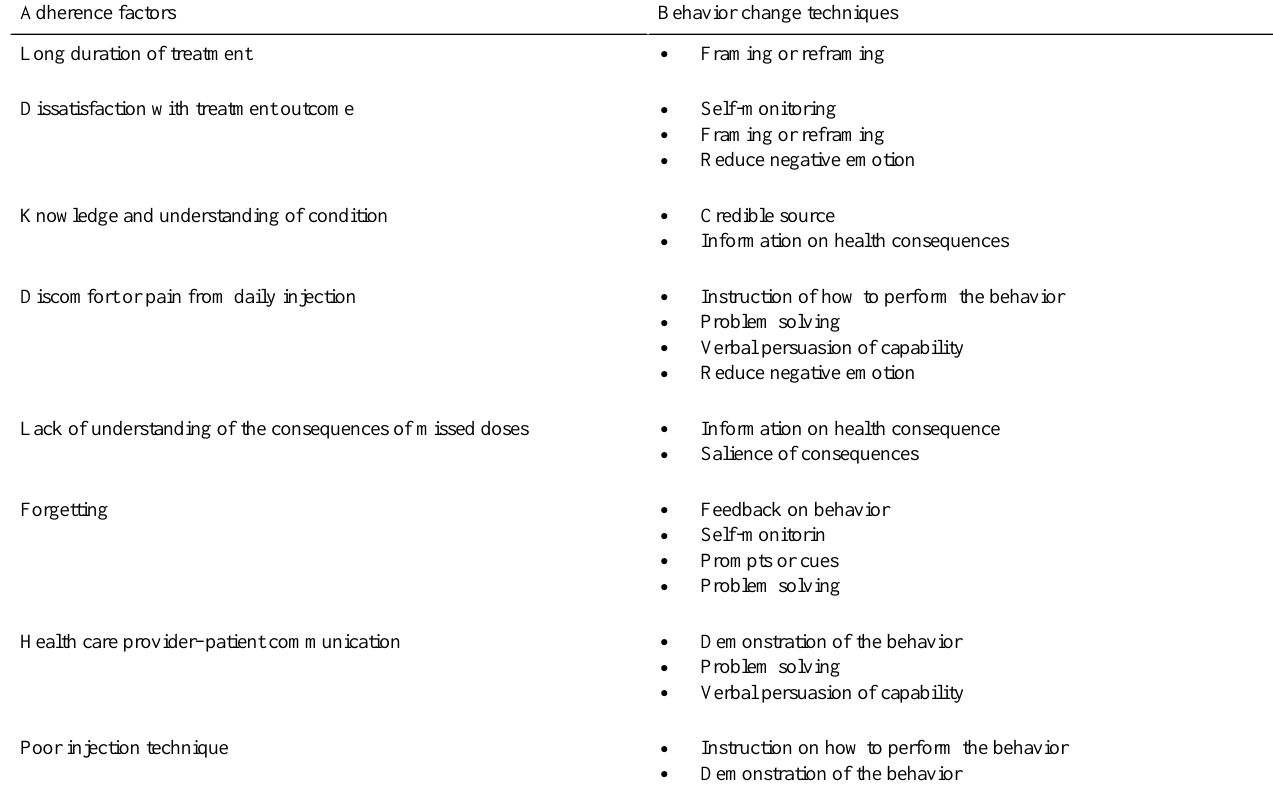
Table 2. COM-B adherence factors and behavior change